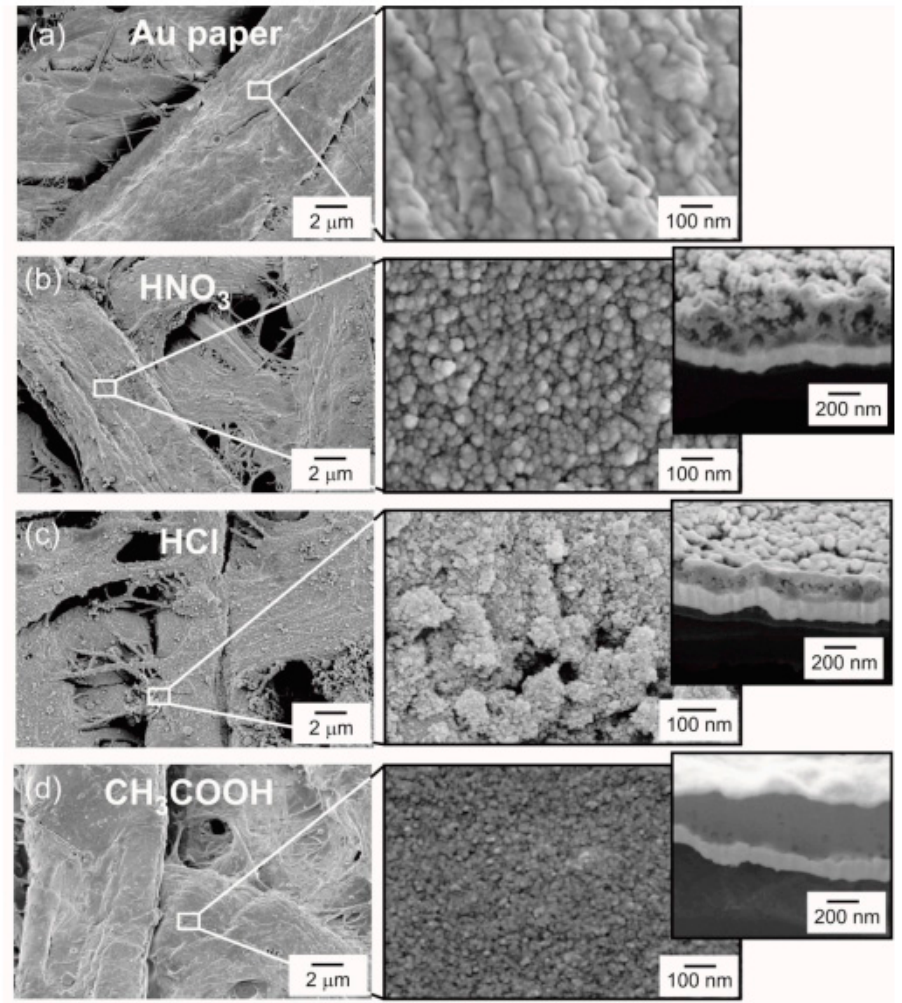
Figure 5. SEM images of the Whatman paper with an Au film and the TiO 2 nanostructured films grown under microwave irradiation to be used as EC devices. Magnified SEM image of the Au film in ( a ) and magnified and cross-section SEM images of the TiO 2 nanostructured films produced with ( b ) nitric acid; ( c ) hydrochloric acid; and ( d ) acetic acid [15]. Reproduced with permission of MDPI [15].